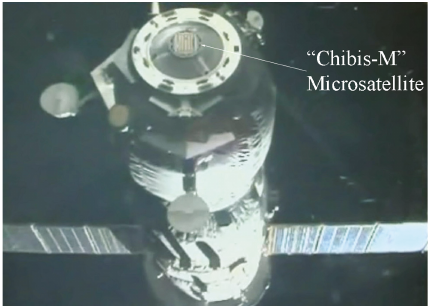
and (b) R reference points. 1 2